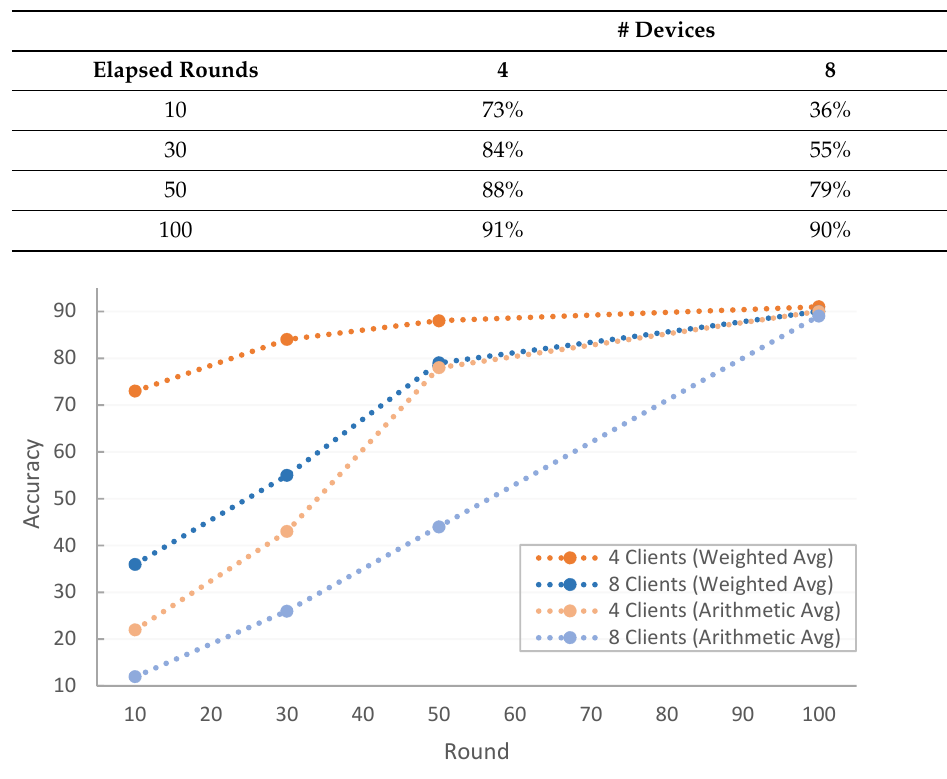
Figure 6. Training 100 Rounds with 4 and 8 Devices (Weighted Average vs Arithmetic